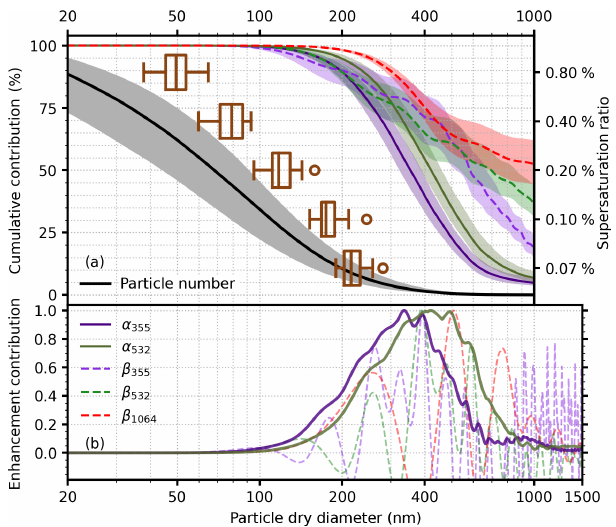
Figure 3. (a) Cumulative contributions (accumulate from large particle size to small particle size) of particle number concentra- tions (measured), dry particle backscatter coefficients (simulated), and dry particle extinction coefficients (simulated). The solid and dashed lines represent the median values of five field campaigns, and the shadows cover from the lower to upper quartile values. The box plots in brown contain statistical information about critical di- ameter of each supersaturation condition (right y axis). The boxes extend from the lower to upper quartile values, with lines at the me- dian. The whiskers extend from the box to the minimum–maximum values or extend from the box by 1.5 times the interquartile range. The markers “o” are the flyers. (b) Normalized size-resolved en- hancement contributions when relative humidity increases from 60% to 90%, which are theoretically calculated by the mean parti- cle number size distribution, the mean black carbon mass concentra- tion (4.717µgm − 3 ), the mean mass ratio of externally mixed black carbon (0.664%), and the mean size-resolved κ